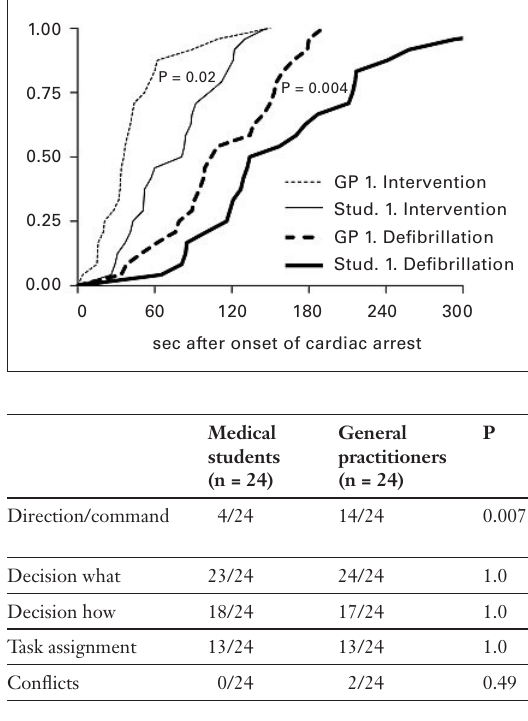
Survival curve of the timing of the first appropriate intervention (defined as first execution of either precordial thump, ventilation, cardiac massage, defibrillation, or injection of drugs) and the first defibrillation in simulated witnessed cardiac arrest.Time 0 denotes the onset of cardiac arrest. Stud = teams composed of three medical students at the time of their graduation and one confederate nurse; GP = teams composed of three general practitioners and one confederate nurse.There was a statistically significant difference between medical students and general practition- ers for both timings (log rank test).